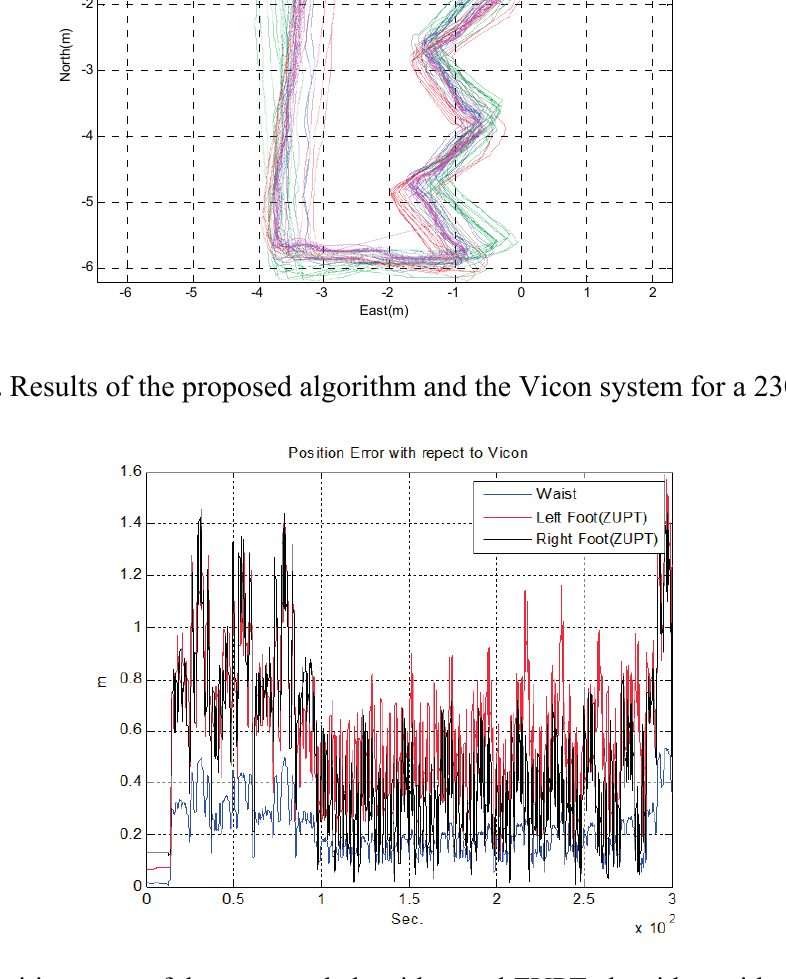
Figure 15. Position error of the proposed algorithm and ZUPT algorithm with respect to the Vicon